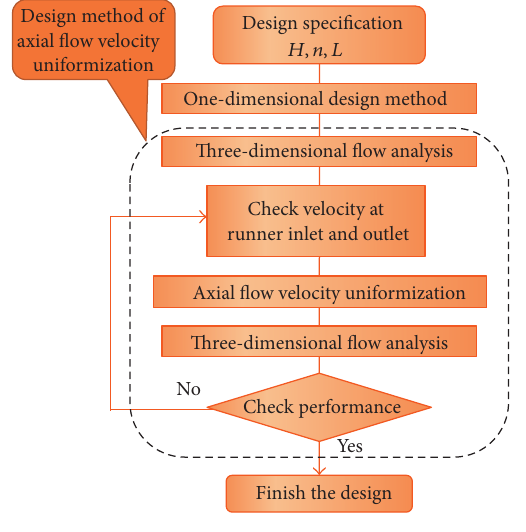
Figure 1: Design